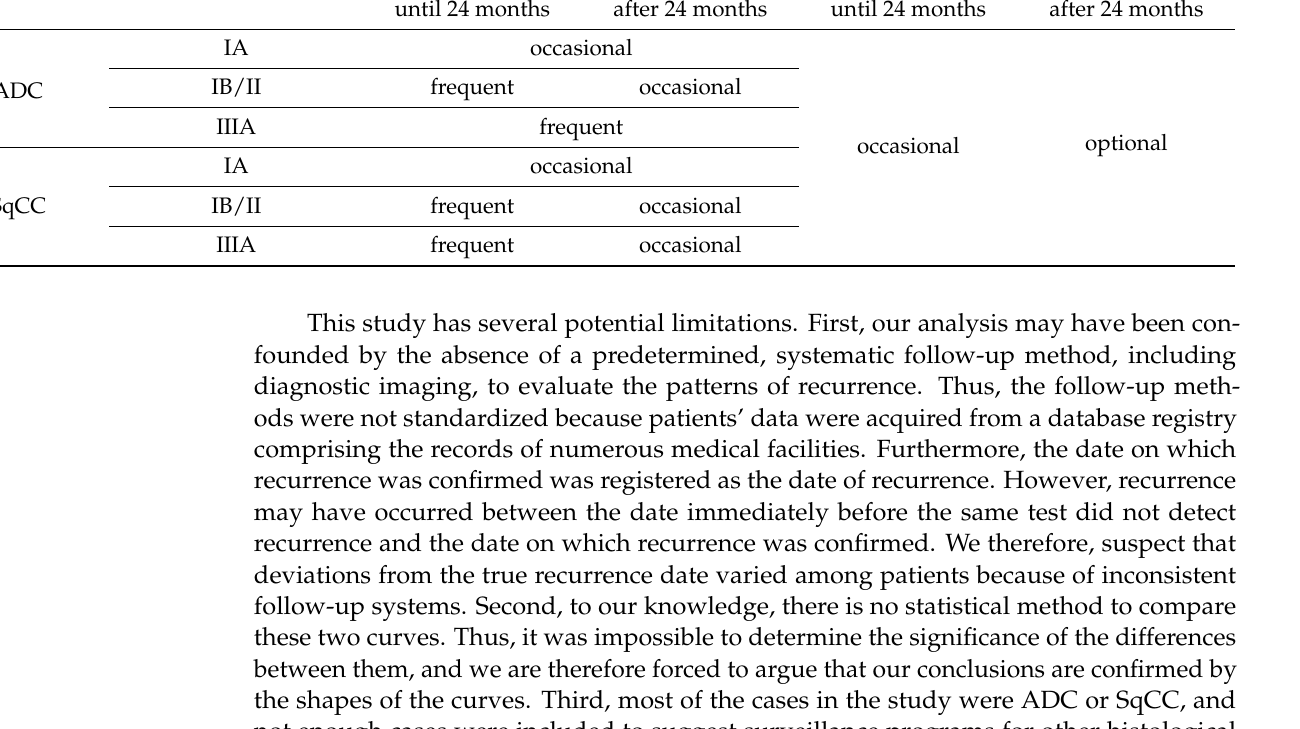
Table 2. Proposed optimal follow-up program after complete resection of lung cancer.